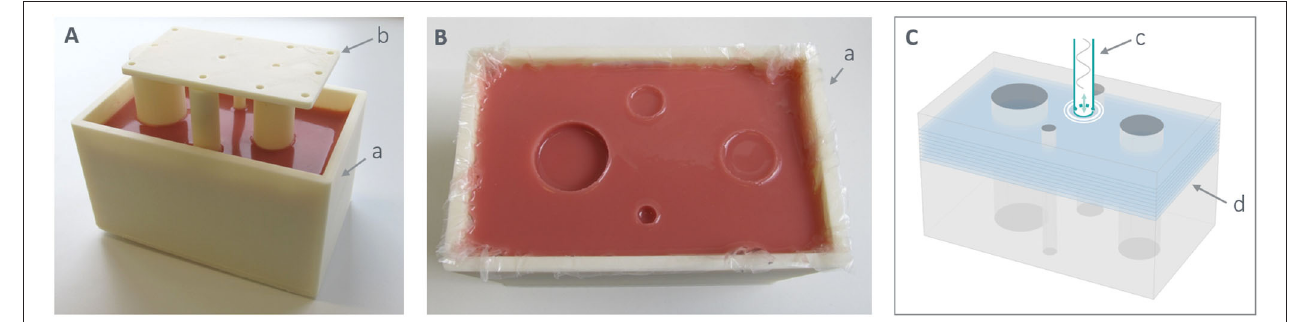
FIGURE 1 | MRE silicone phantom. (A) Example of the fabrication process of the background with the four cylinders positioned by means of an aligning lid (b). (B) Picture of the silicone phantom with four cylindrical inclusions in the 3D-printed rectangular mold (a). (C) 3D design of the phantom with the four inclusions that shows the position of the vibration source (c) at its surface as well as the location of the acquired or exported nine slices (in blue) in the case of (3mm) 3 voxel size